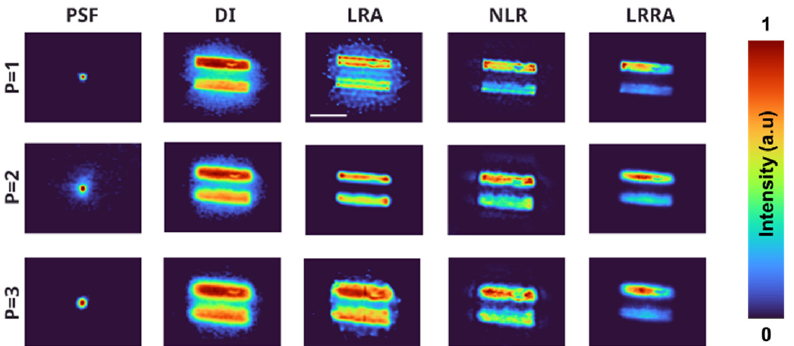
Figure 7. Images of the PSF, DI of the test object—1, reconstruction results using LRA, NLR and LRRA. The scale bar has a length of 1 mm.